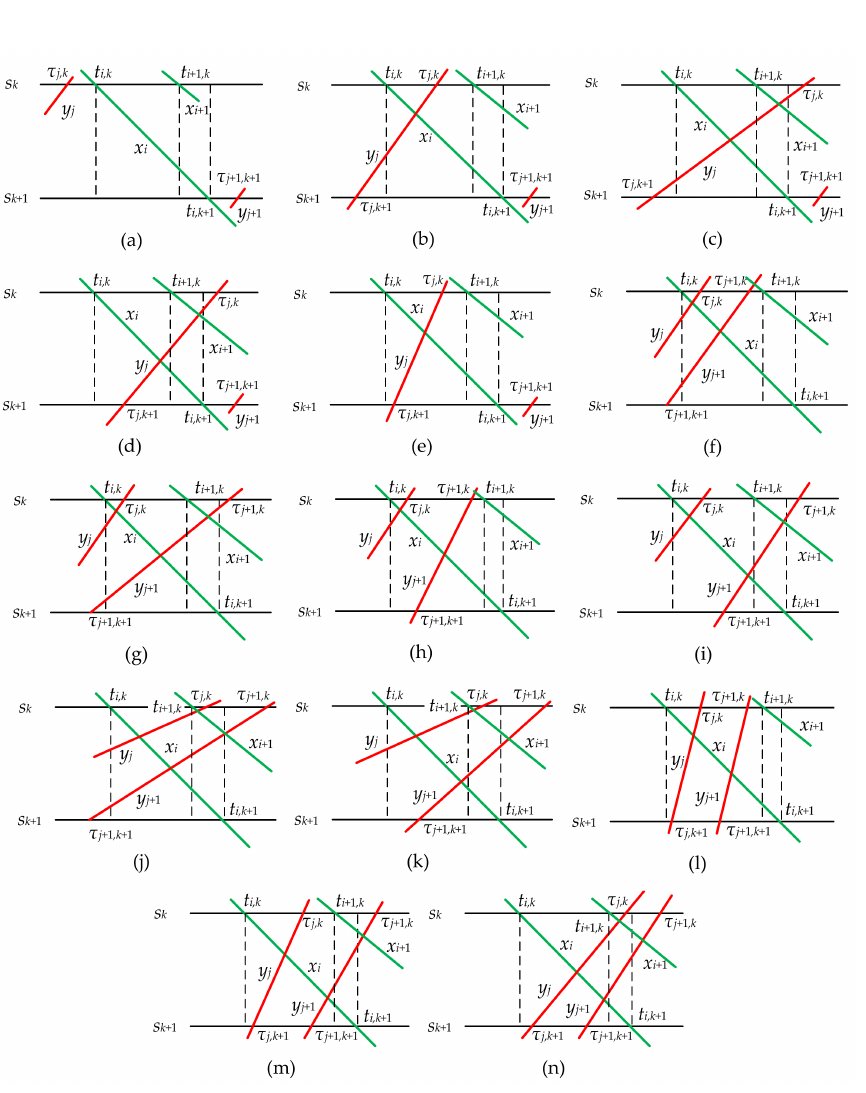
Figure 7. The train diagram of train x i , x i+ 1 , y j and y j+ 1 in ( t i , k , t i , k+ 1